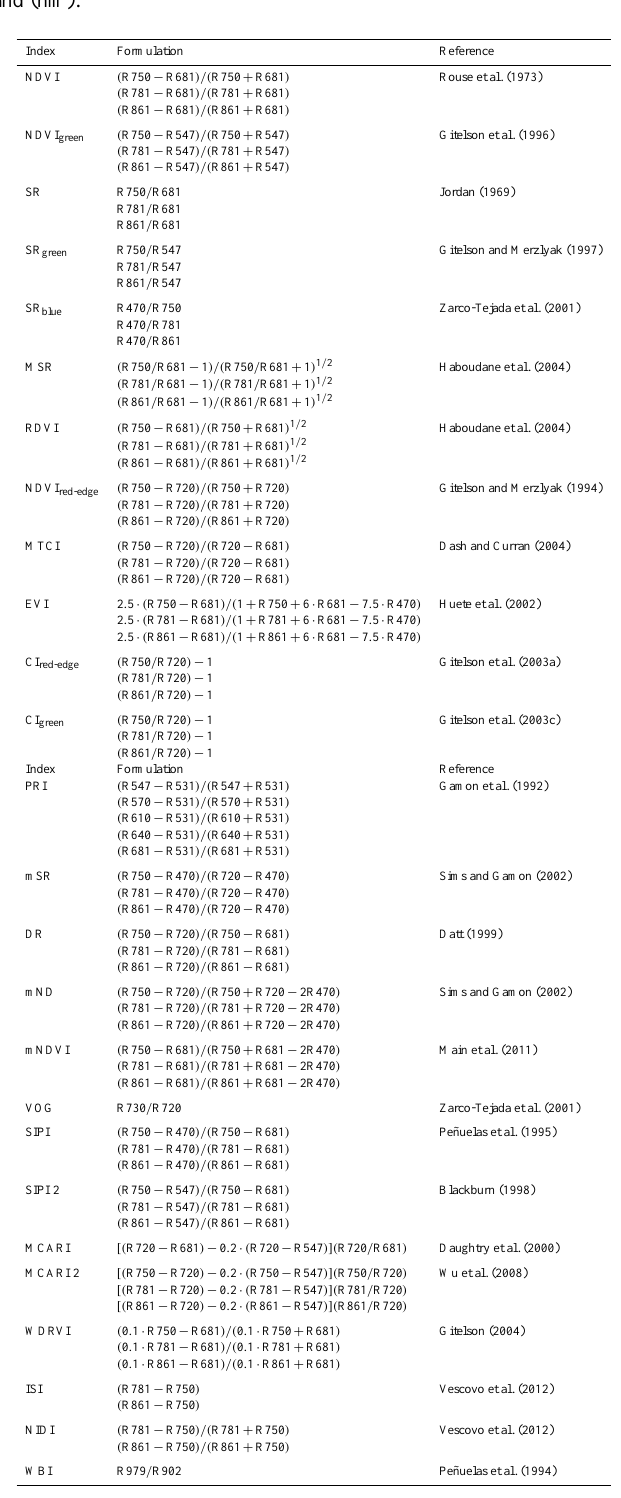
Table A1. Spectral vegetation indices investigated in this study. R refers to reflectance at a specific band